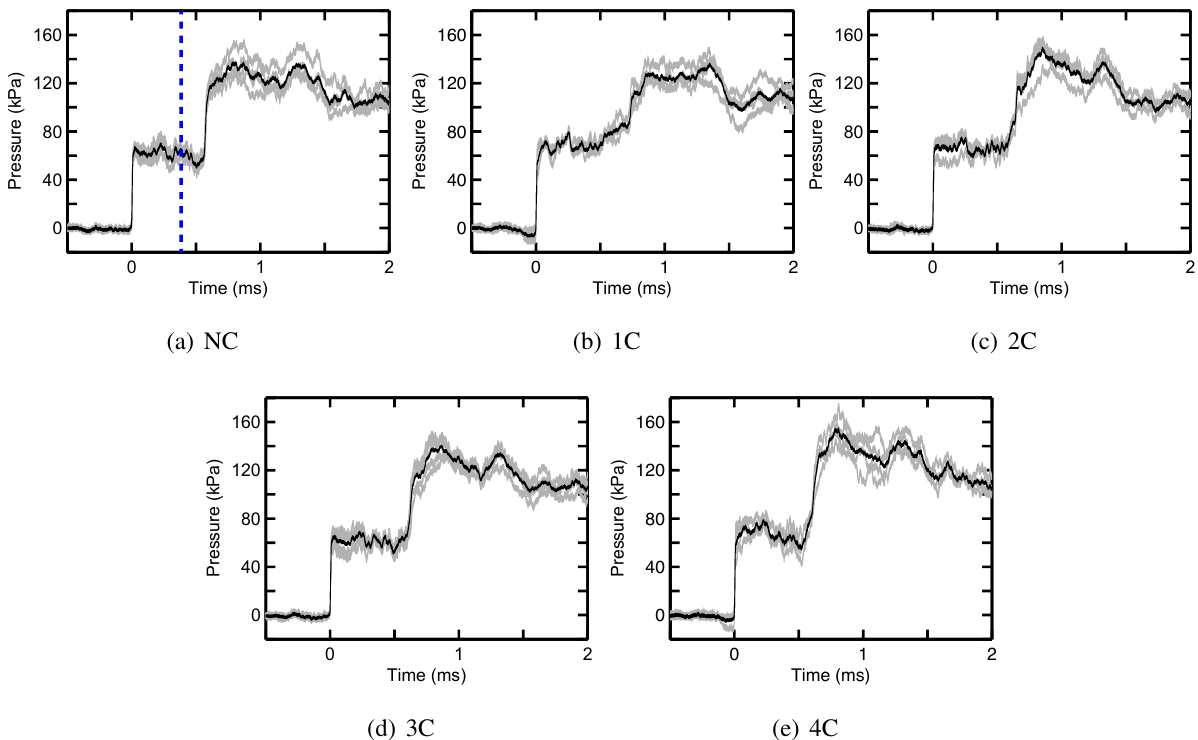
Figure 14. Open cell foam pressure recordings for all cases: incident and reflected